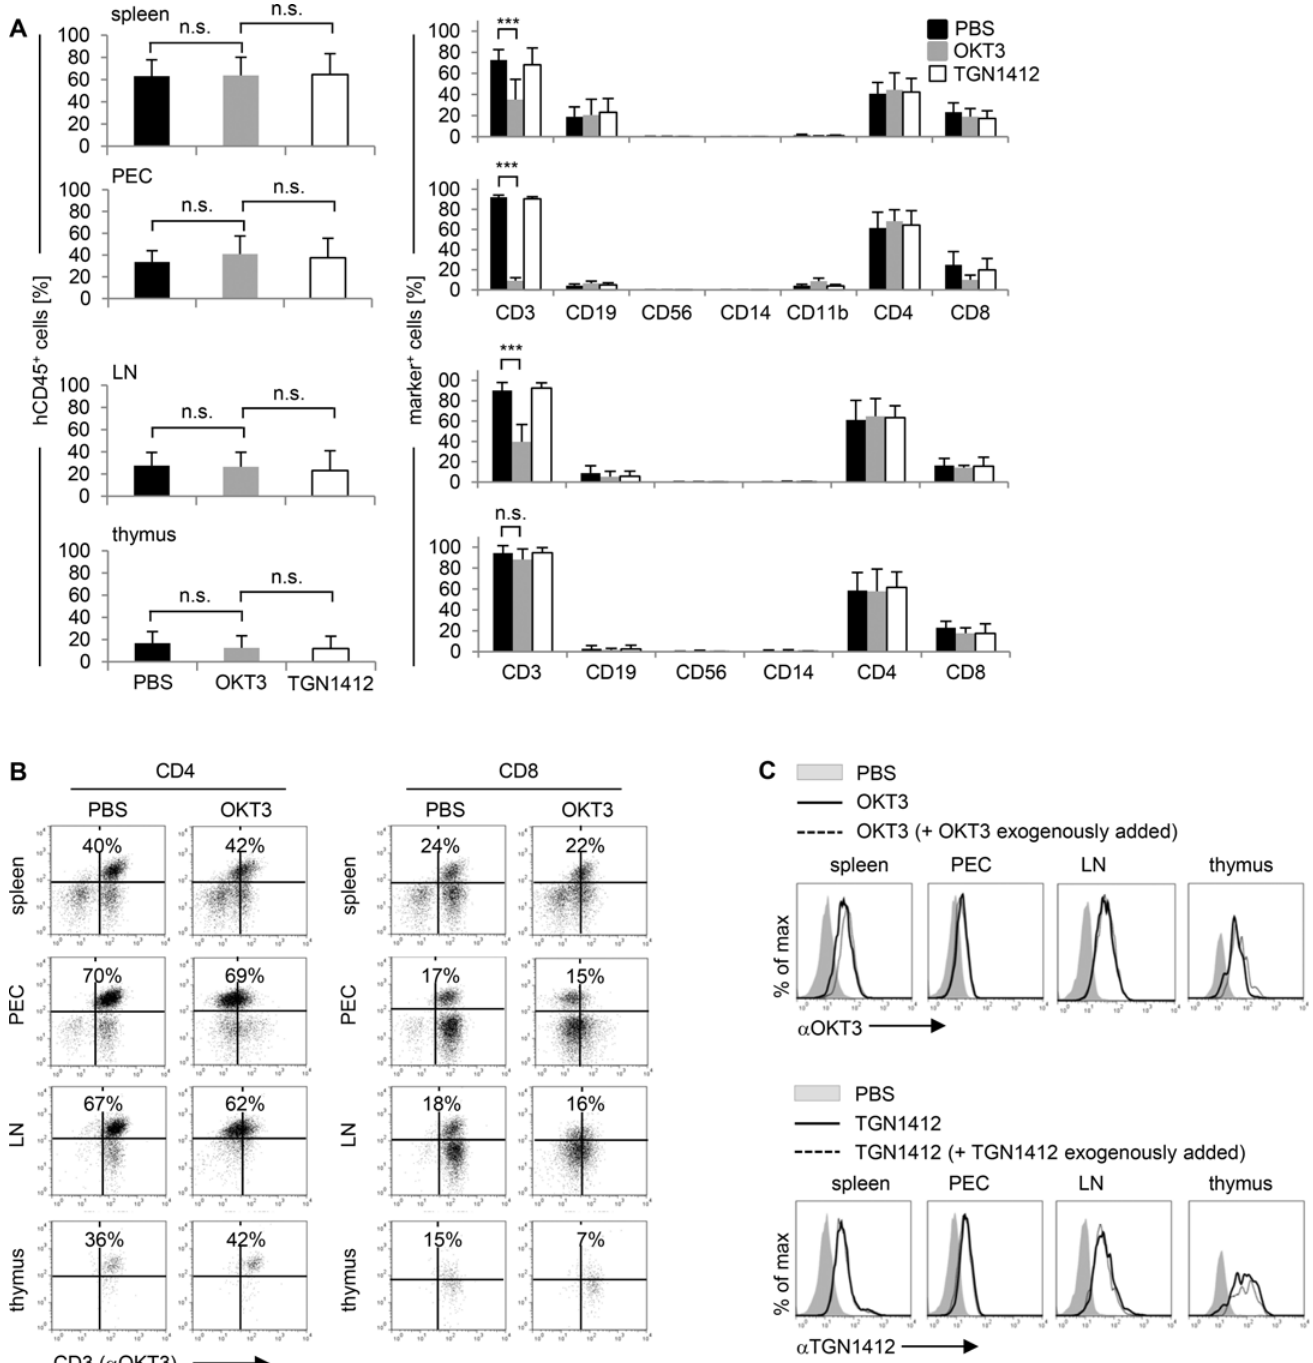
Fig 3. OKT3 application selectively downmodulates CD3 on T cells in humanized mice. Humanized mice were injected i.v. with 20 μ g OKT3 or 20 μ g TGN1412 per 10 grams body weight. (A) 2 – 6 hours (time point of sacrifice) post OKT3 (gray bars; n = 6 – 16) or TGN1412 (white bars; n = 6 – 16) application, percentage and composition of hCD45 + cells in spleen, PEC, LN, and thymus of humanized mice were analyzed by flow cytometry. PBS-treated mice (black bars; n = 6 – 16) were used as control. *** p < 0.001; n.s., not significant (t-test, for comparison of hCD45 + cells adjusted according Dunnett for multiple comparisons). (B) 4 hours post OKT3 (n = 3) application, CD3 expression on hCD4 + or hCD8 + T cells in spleen, PEC, LN, and thymus of humanized mice was analyzed by flow cytometry. PBS-treated mice (n = 3) were used as control to adjust quadrants for definition of positive and negative cells. Data from one individual animal, being representative for the indicated groups, are shown. (C) 4 hours post OKT3 (n = 3) or TGN1412 (n = 3) application, mAbs bound by their target CD3 or CD28 on human CD4 + /CD8 + T cells in spleen, PEC, LN, and thymus of humanized mice were analyzed by flow cytometry (black curves).